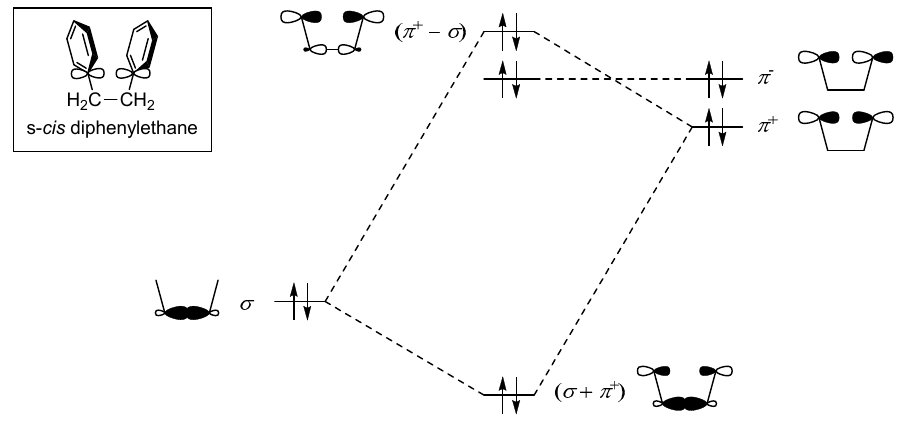
Figure 2. Schematic view of through-bond interaction in the diphenylethane model.